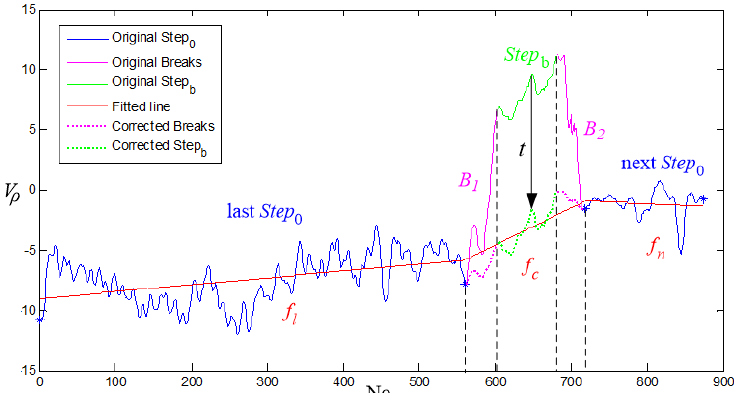
Figure 8. Break between point 𝑃 𝑗−1 and 𝑃 𝑗 in polar coordinate system, in which 𝑂 𝑐𝑘 denotes the pole, 𝜌 and 𝜃 denote polar coordinates, 𝑅 𝑐𝑘 is radius of the fitted circle, 𝑉 𝜌 is radial distance between contour point and the fitted circle, d𝐷𝑃(𝜃 𝑗 ) and d𝜃 𝑗 are radial and angular difference between the two points, and α is the angle between line 𝑃 𝑗−1 𝑃 𝑗 and radial direction at point 𝑃 𝑗 .